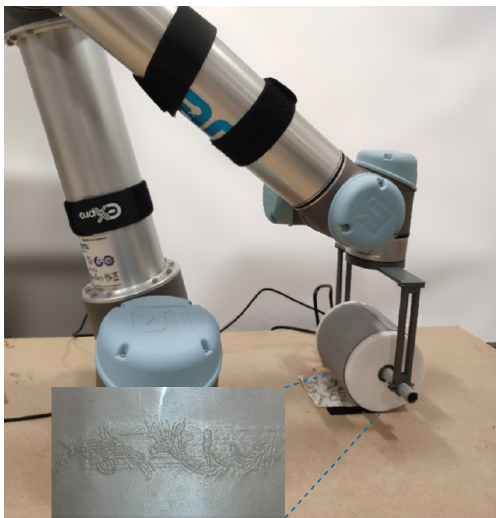
Figure 1. Our TouchRoller sensor mounted on the end of a UR5 robot arm is rolling over a piece of fabric to collect the surface texture, and the collected tactile image of the fabric texture is shown on the bottom